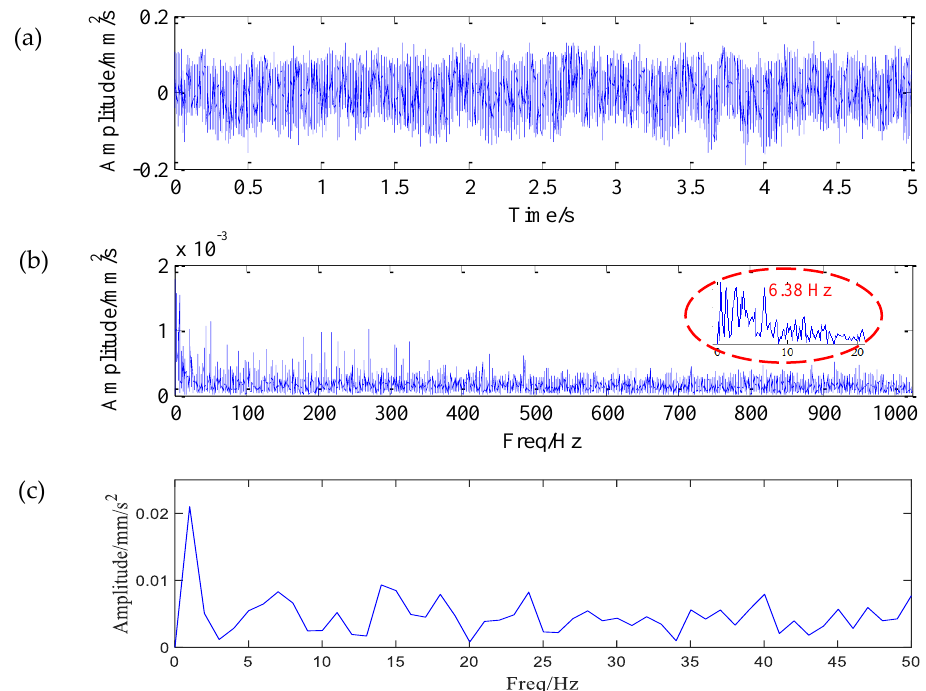
Figure 18. Vibration signal of the left pitching moving drivetrain: ( a ) waveform and ( b ) spectrum ( c ) envelope spectrum.